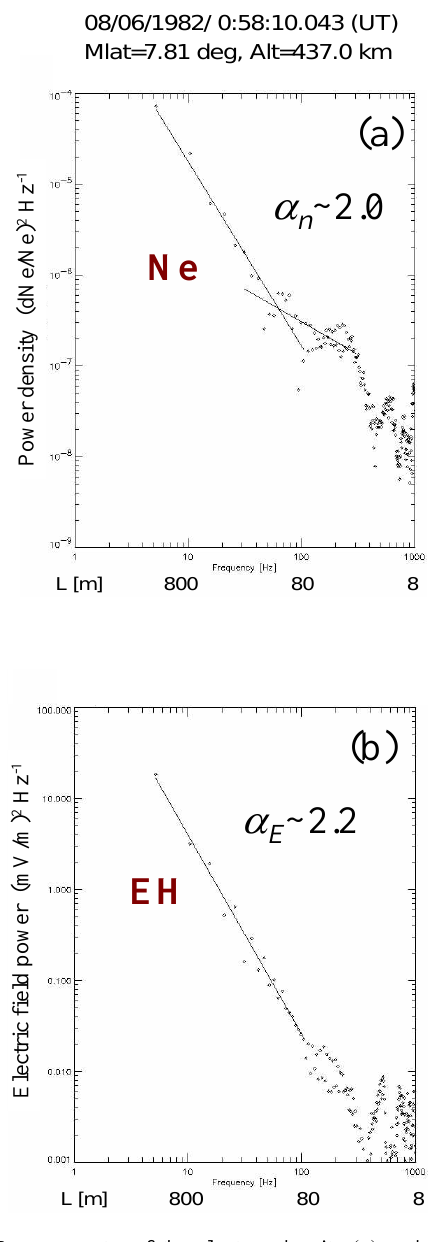
8 June pass. The arrow in Fig. 1a indicates the time of the above mentioned spectrum for the electron density fluctua- tion taken inside the ESF.